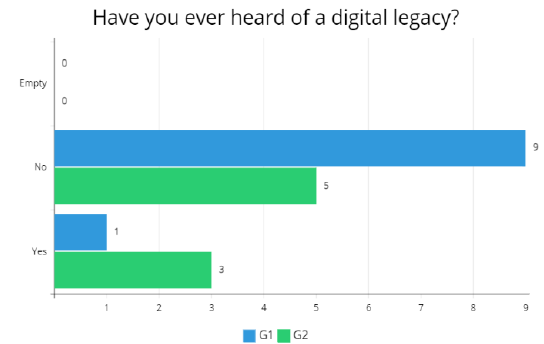
Figure 8. Have you ever heard of a digital legacy ­ G1 and